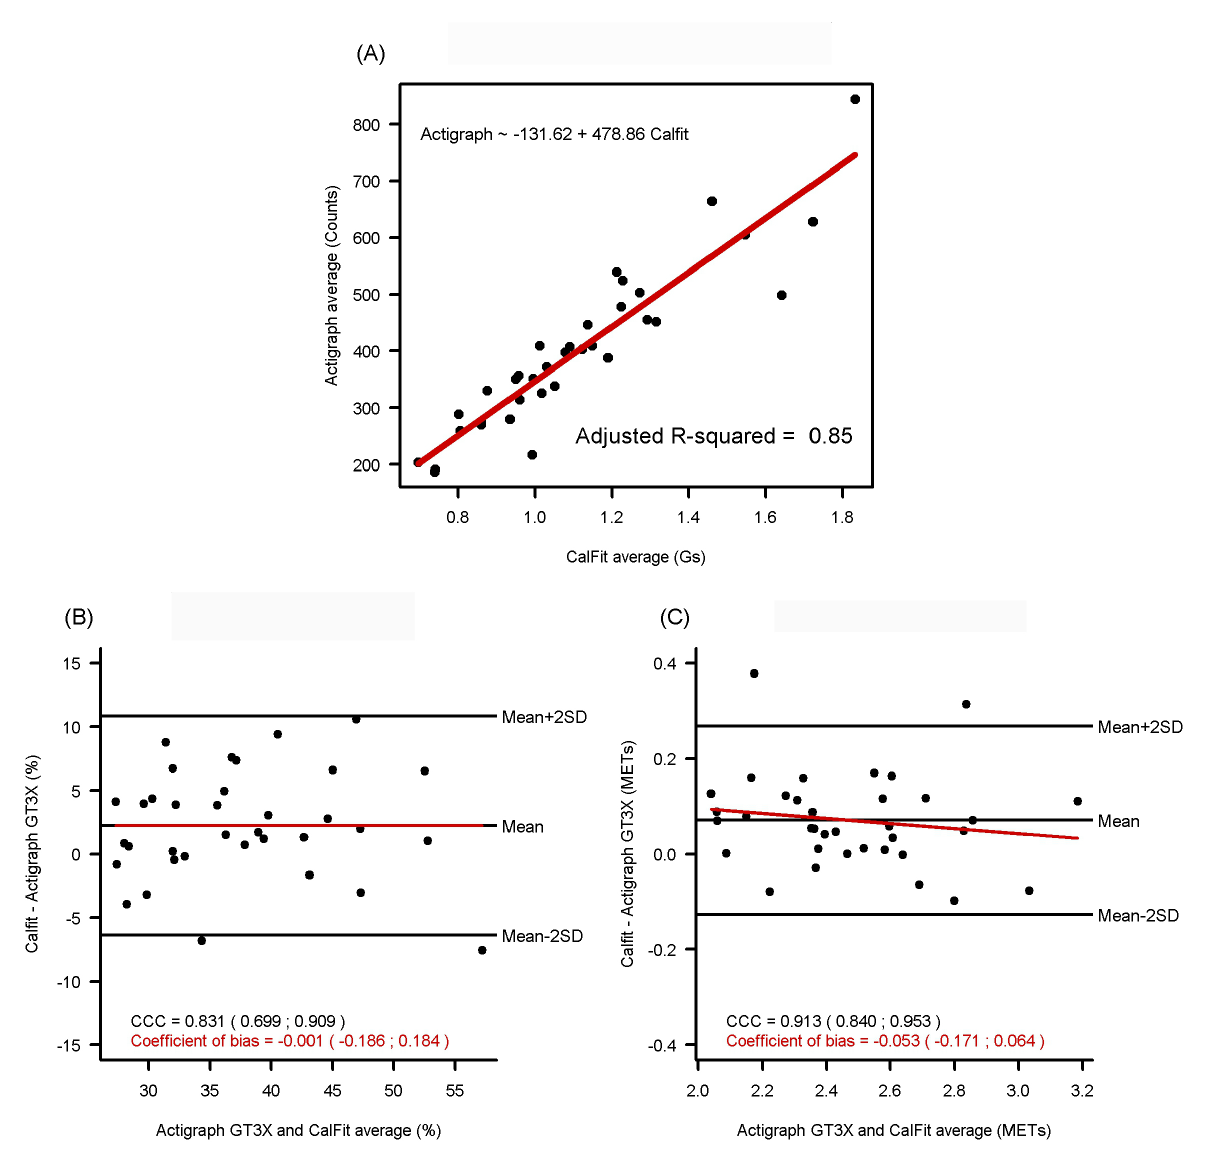
Figure 2. Agreement between CalFit and Actigraph GT3X in vertical axis, duration, and energy expenditure in physical activity within the coinciding